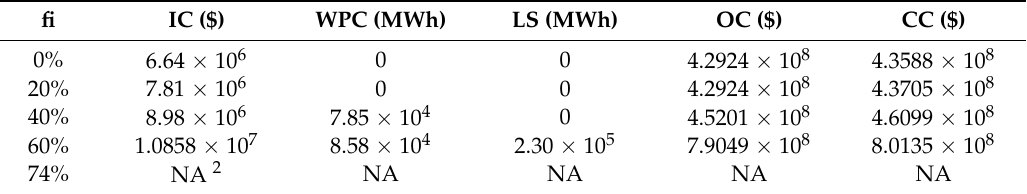
Table 4. RTEP results obtained under different levels of wind power deviation intensity β